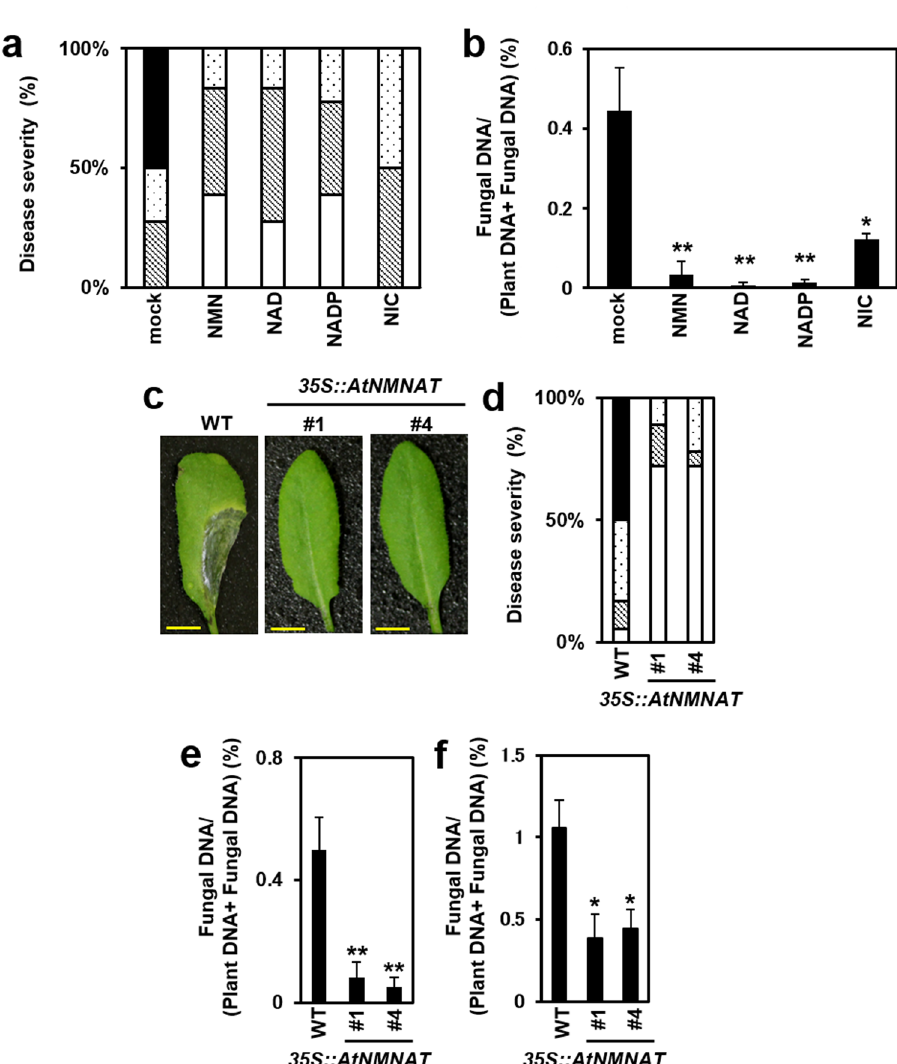
Figure 4. The effects of pretreatment with pyridine nucleotides and overexpression of the NMNAT gene on disease resistance against F. graminearum in Arabidopsis. Water (mock), NMN, NAD, NADP and NIC (0.3 mM) were sprayed onto the surface of Arabidopsis rosette leaves prior to incubation for 6 h. A conidia solution (1 × 10 5 conidia/ml) of F. graminearum was then injected into leaves. ( a ) The disease severity was evaluated by the visible symptoms of inoculated leaves 3 days after inoculation (n = 18). Open box: normal, cross-hatched box: colour change, dot box: partial aerial mycelium, closed box: expanded aerial mycelium. ( b ) Pretreatment with pyridine nucleotides was carried out as described above. F. graminearum gDNA was measured by qPCR. Error bars represent the standard deviation (n = 3) (Student’s t-test * P < 0.05 ** P < 0.01). ( c ) Transgenic plants ( 35 S::AtNMNAT ) show enhanced disease resistance. Conidia solutions (1 × 10 5 conidia/ml) of F. graminearum were inoculated into transgenic plant ( 35 S::AtNMNAT ) leaves and flower buds. Photographs of representative leaves from WT and transgenic plants ( 35 S::AtNMNAT ) at 3 days after inoculation. Scale bars: 1 cm. ( d ) The disease severity was evaluated by the disease symptoms of inoculated leaves 3 days after inoculation (n = 18). Open box: normal, cross-hatched box: colour change, dot box: partial aerial mycelium, closed box: expanded aerial mycelium. ( e ) F. graminearum gDNA was measured by qPCR in inoculated leaves. Error bars represent the standard deviation (n = 3) (Student’s t-test ** P < 0.01). ( f ) F. graminearum gDNA was measured by qPCR in inoculated flower buds. Error bars represent the standard deviation (n = 3) (Student’s t-test * P <